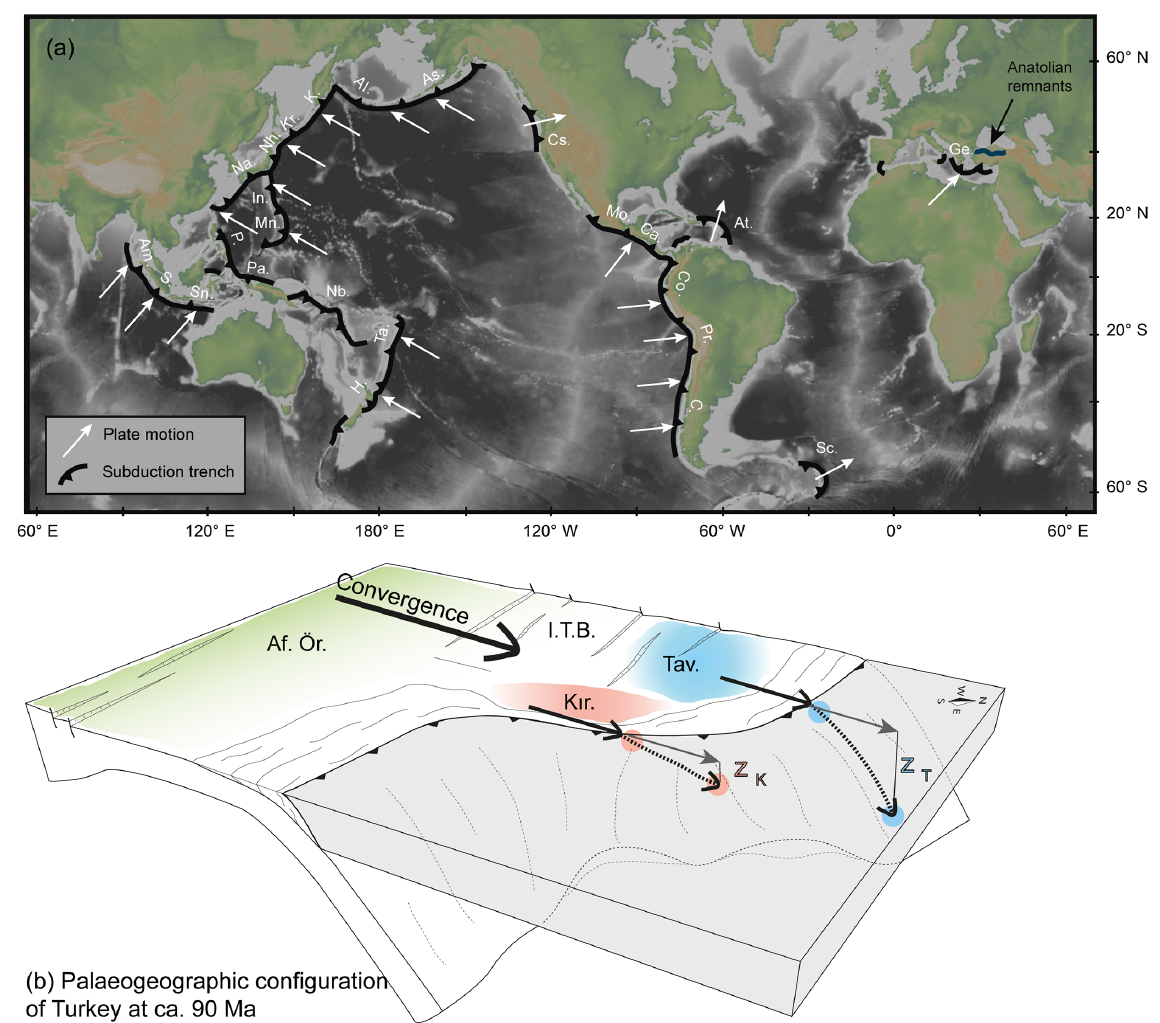
Figure 1. (a) Plate motion at trenches from the NNR-MORVEL model (Argus et al., 2011). Base layer obtained with GeoMapApp (http://www.geomapapp.org, last access: 7 June 2018) with topography and bathymetry from Ryan et al. (2009). Abbreviations as follows: Am., Andaman; As., Alaska; Al., Aleutians; At., Antilles; Ca., Central America; C., Chile; Co. Colombia; Cs., Cascadia; Ge., Greece; H., Hikurangi; In., Izu-Bonin; Nh., Japan; K., Kamchatka; Kr., Kurile; Mn., Marianas; Mo., Mexico; Nb., New Britain; Pa., Palau; Pr., Peru; P., Philippine; S. Sumatra; Sc. Scotia; Sn., Sunda; Ta., Tonga. (b) Possible paleogeographic configuration at ca. 90Ma for central Turkey based on the reconstruction of van Hinsbergen et al. (2016). Abbreviations correspond to the following units: Af.Ör., Afyon–Ören zone; I.T.B. Inner Tauride Basin; Kır., Kır¸sehir block; Tav., Tav¸sanlı zone. Z K and Z T refer to the maximum burial of the Kır¸sehir and Tav¸sanlı units as discussed in the